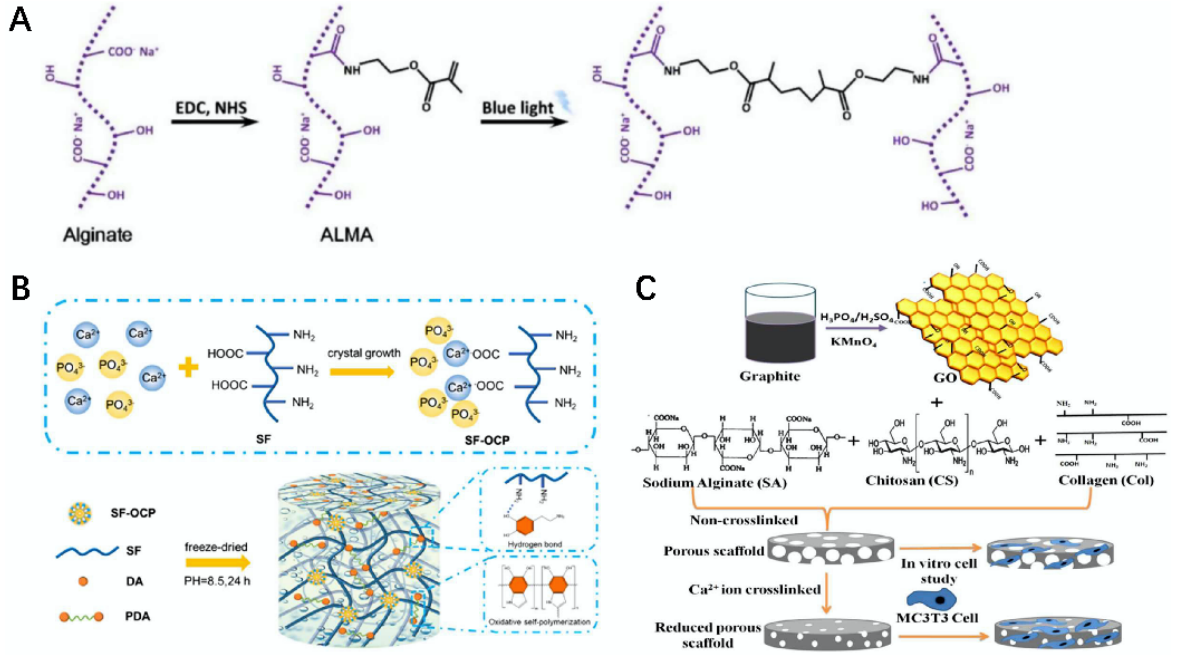
Figure 9. Schematic diagram of biomodification and preparation of bio-scaffolds using related natural materials. ( A ) Schematic diagram of the modification of ALMA using alginate [158]. ( B ) Schematic diagram of the preparation of SF/OCP/PDA scaffold [159]. ( C ) Schematic diagram of the prep-